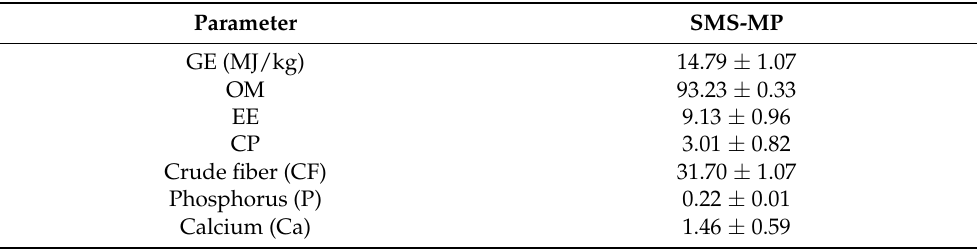
Table 3. Chemical composition of dried SMS-MP (%,